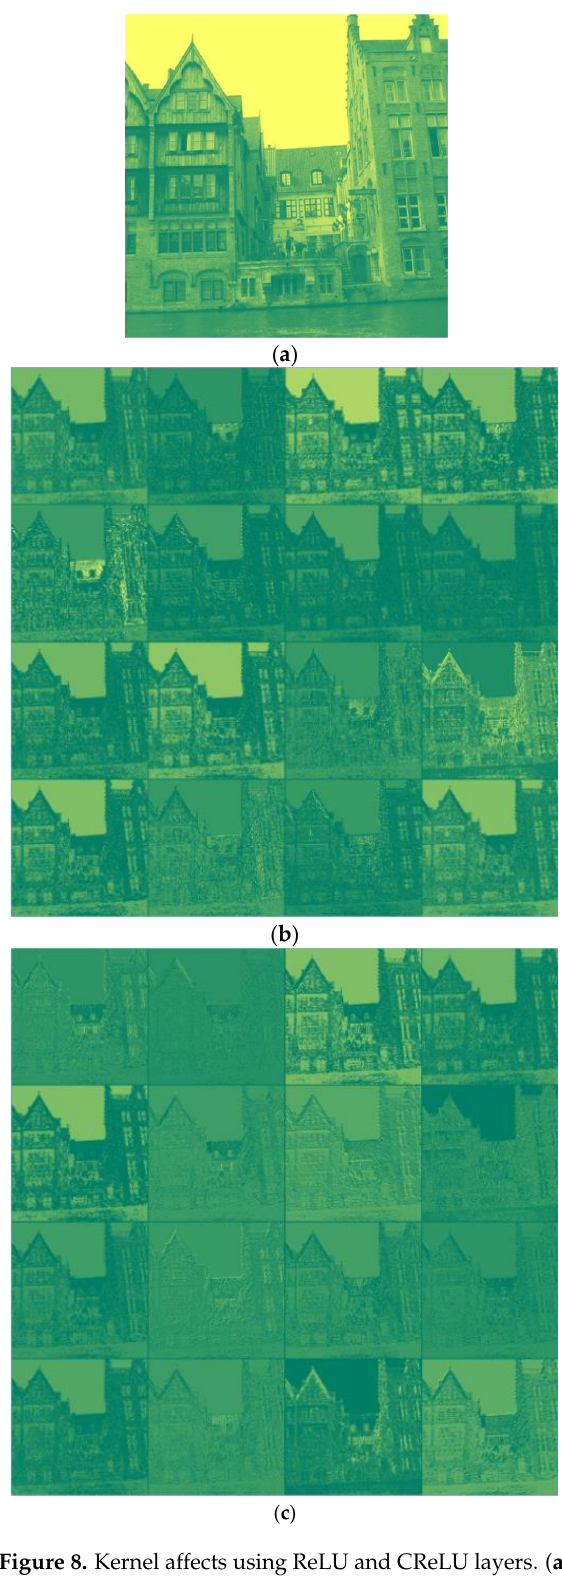
Figure 8. Kernel affects using ReLU and CReLU layers. ( a ) An image. ( b ) Layer 9 kernels with ReLU. ( c ) Layer 9 kernels with CReLU.